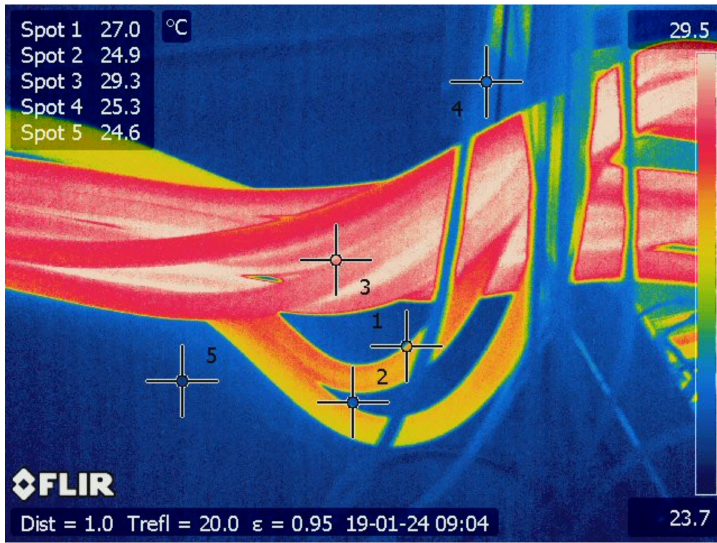
Figure 7. Current in cables visible due to increased